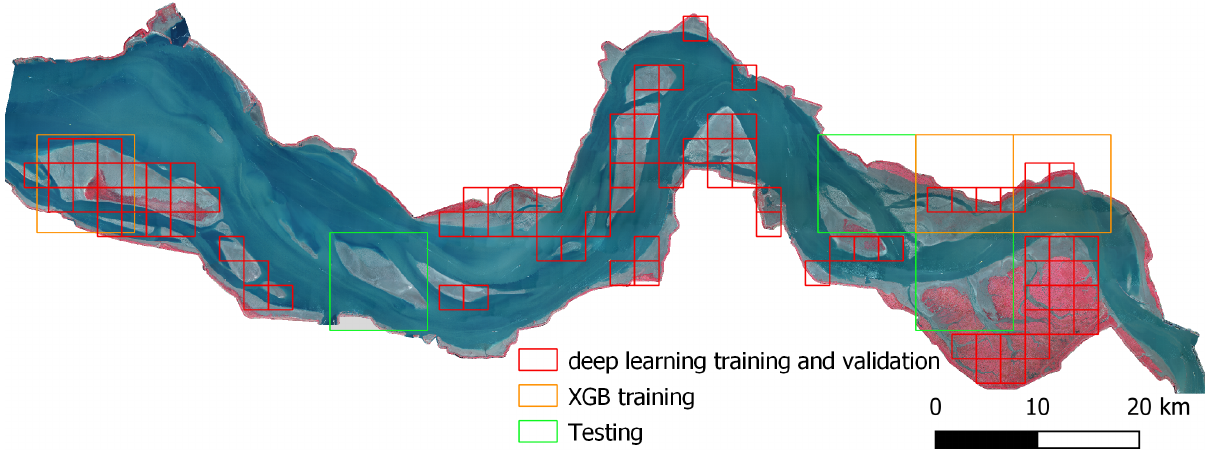
Figure 2. Training, validation, and test areas used by the machine learning methods, Western